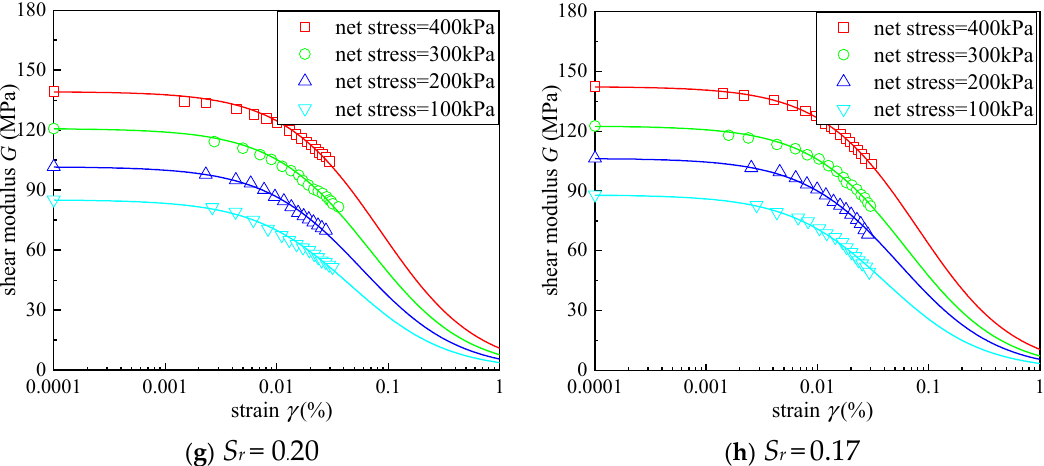
Figure 8. Relationship between shear modular G and shear strain γ for specimens at different saturations:( a ) S r = 1; ( b ) S r = 0.92; ( c ) S r = 0.65; ( d ) S r = 0.50; ( e ) S r = 0.40; ( f ) S r = 0.30; ( g ) S r = 0.20; ( h ) S r = 0.17.